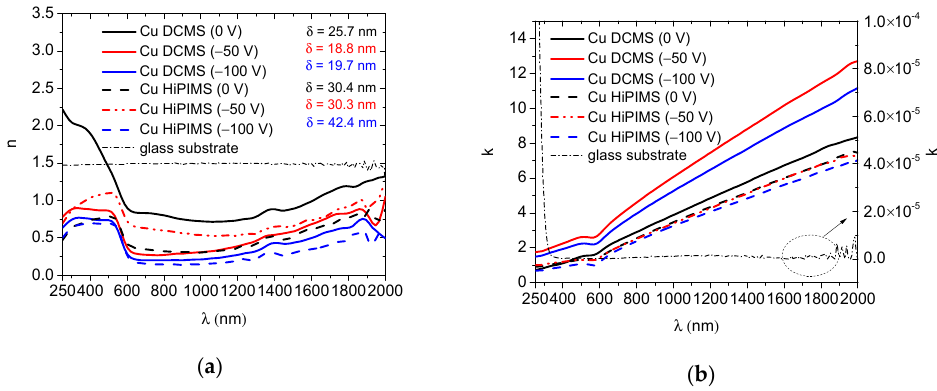
Figure 4. Refractive indices ( a ) and extinction coefficients ( b ) of copper films in DCMS and HiPIMS mode derived from transmission and reflectance spectra.